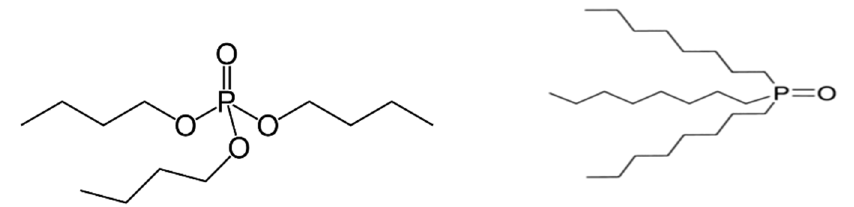
Figure 4. Chemical structure of tri- n -butyl phosphate (TBP) and trioctylphosphine oxide (TOPO). Compared with other ligands, such as β -diketones, TBP is moderately powerful when used alone. Its affinity for metal ions is derived from its phosphoryl group, forming O-bonded coordinate links: (C 4 H 9 O) 3 P=O → M.